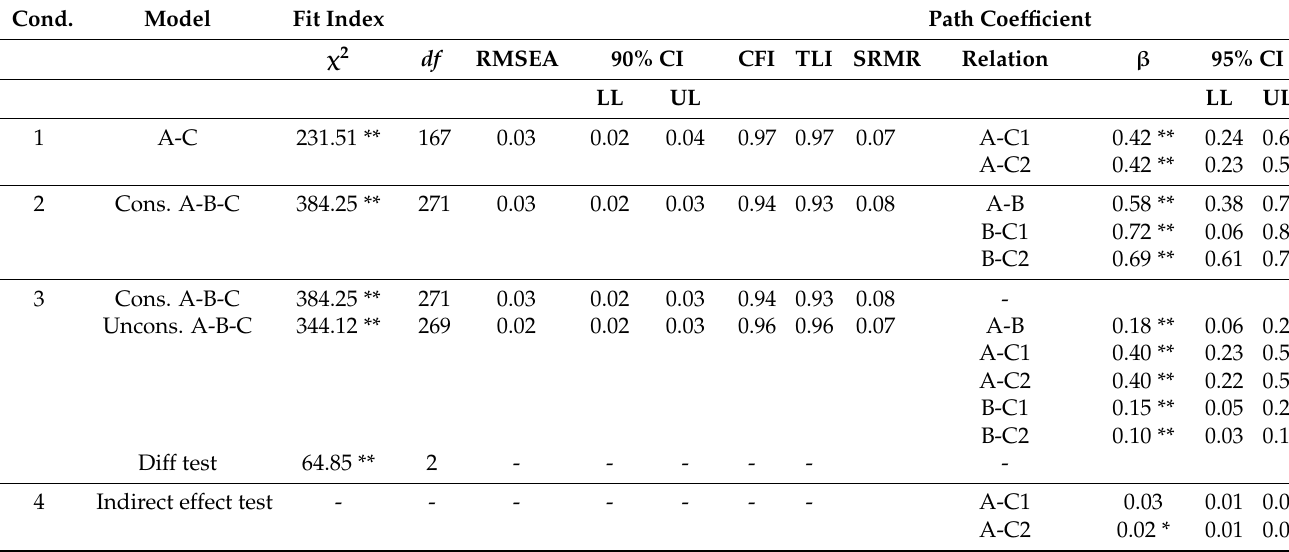
Table 5. Fit indices and path coefficients for the mediation model for